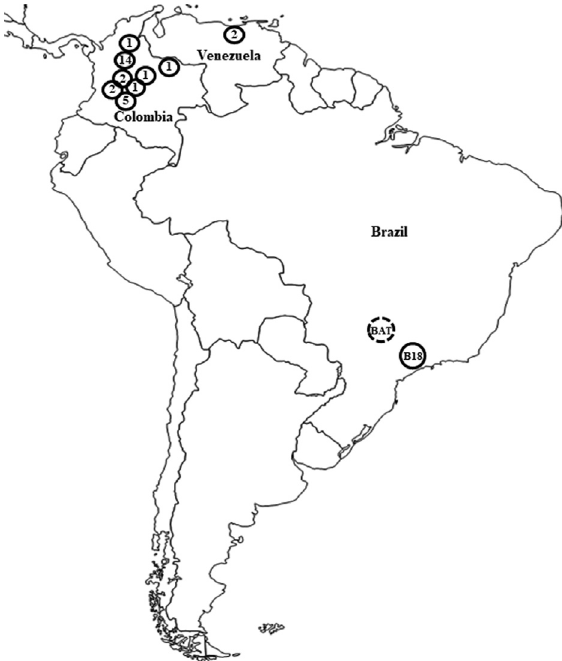
Figure 3 - Geographic distribution of human and environmental isolates of P. restrepiensis (PS3 genotype) in South America. Each circle repre- sents the identified isolates and their respective regions (Colombia and Venezuela) according to reports in the literature (Matute et al. , 2006; Muñoz et al. , 2016; Roberto et al. , 2016). In Brazil: BAT clinical isolate (PCM-subacute form) isolated from a patient in the macro-region of Ribeirão Preto, São Paulo State, Brazil, and B18 or Pb339 was isolated from a patient in the state of São Paulo,